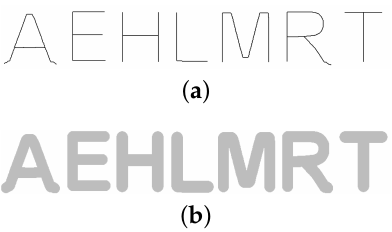
Figure 13. ( a ) Seven unit-width letters used as ground truths for MSD measurements. ( b ) Thickened digital patterns from ( a ) used for the investigations of MR, NI and MSD.